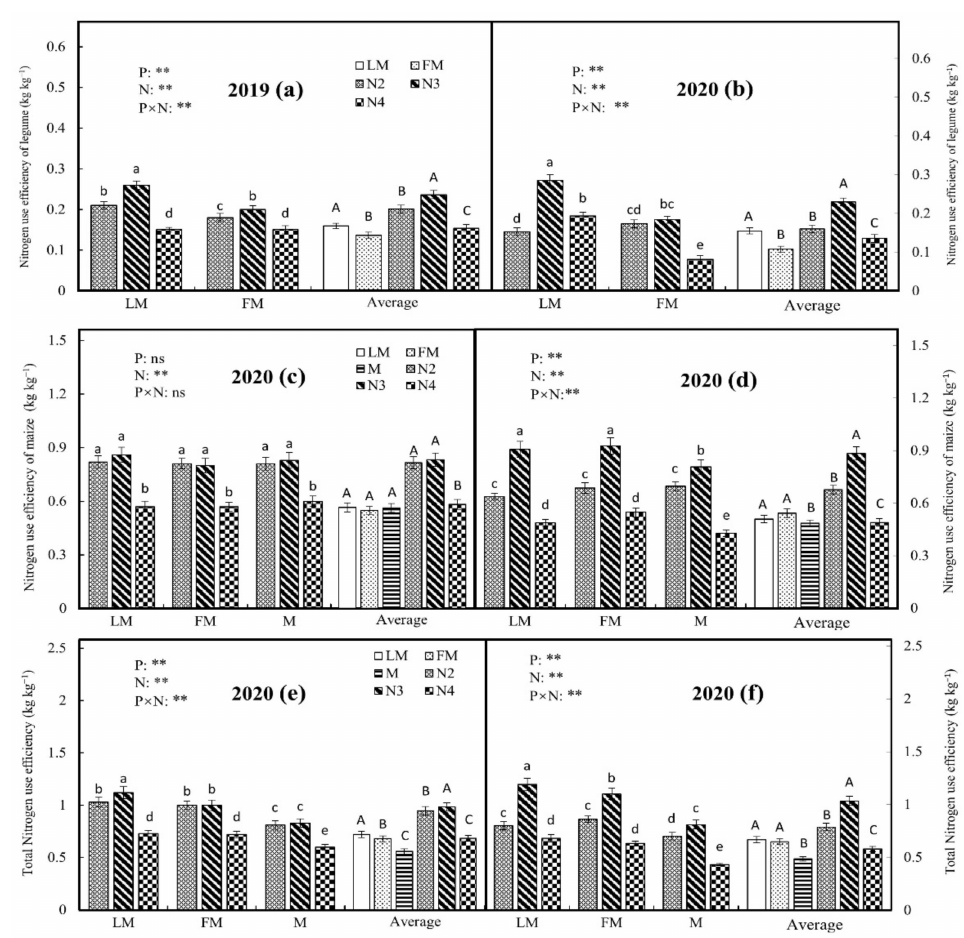
Figure 6. N-use efficiency of legumes, maize, and intercropping systems under different treatments in 2019 and 2020. Note: ( a ), fresh yield of legume in 2019; ( b ), fresh yield of legume in 2020; ( c ), fresh yield of maize in 2019; ( d ), fresh yield of maize in 2020; ( e ), total fresh biomass yield in 2019; ( f ), total fresh biomass yield in 2020. M, silage maize monoculture; FM, intercropping of fodder soybean and silage maize; LM, intercropping of Dolichos lablab and silage maize; N2, 120 kg ha − 1 N; N3, 240 kg ha − 1 N; N4, 360 kg ha − 1 N. P, N, and P × N represent planting patterns, N application, and interaction between them, respectively; ** p < 0.01; ns, no significant difference. Different lowercase letters in the same series indicate significant differences among different treatments for the same forage ( p < 0.05). The different uppercase letters in the same series indicate significant differences among different levels of factors for the same forage ( p <